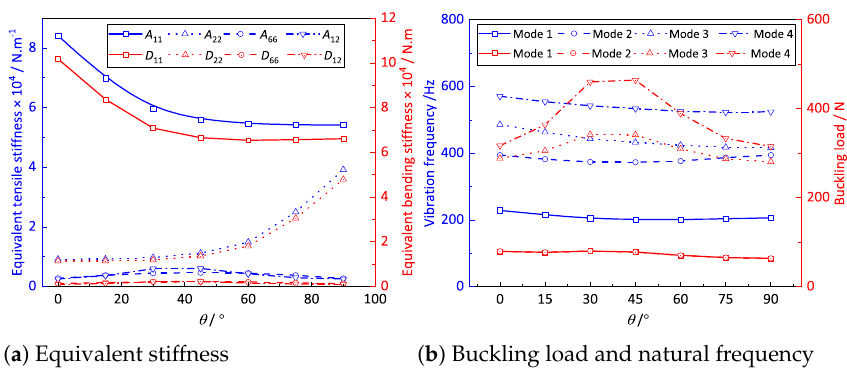
Figure 14. Effects of the layup configuration on the effective performances of the OSFP. 4.4. Influence of 0 ◦ -Ply Ratio on the Effective Performance of OSFP The 0 ◦ ply ratio r was the ratio of the number of 0 ◦ -ply to the total number of ply. To study the influence of 0 ◦ -ply ratio on the effective performance of the panel, the 10- layered laminate with combination of 0 ◦ and 45 ◦ plies was considered, and the six layup configurations are illustrated in Figure 15.